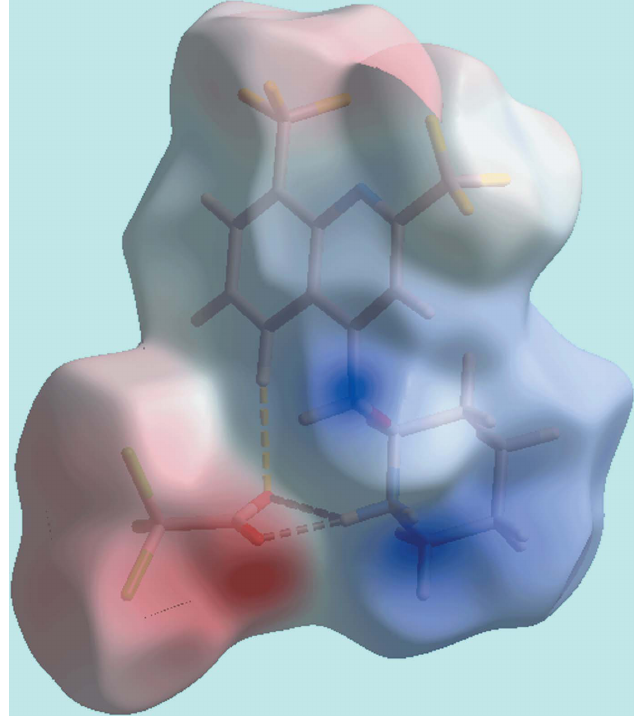
Figure 5 A view of the Hirshfeld surface of (I) mapped over the electrostatic potential in the range (cid:3) 0.128 to + 0.215 a.u. The red and blue regions represent negative and positive electrostatic potentials, respectively.